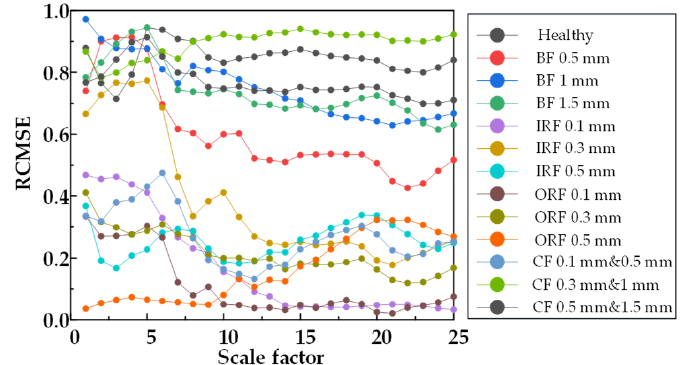
Figure 20. RCMSE entropy values of 25 scale factors under different damage degrees.